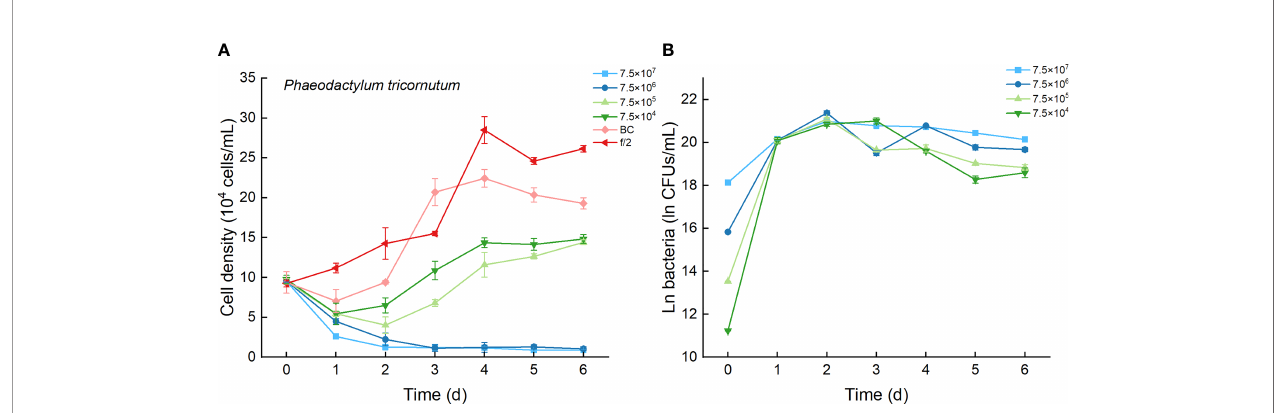
FIGURE 6 | The growth of Phaeodactylum tricornutum in the co-cultures with different concentrations of bacterial strain Lf7 (7.5×10 4 -7.5×10 7 CFUs/mL). (A) Growth curves of P. tricornutum in co-cultures with Lf7, (B) Lf7 concentration in the algal